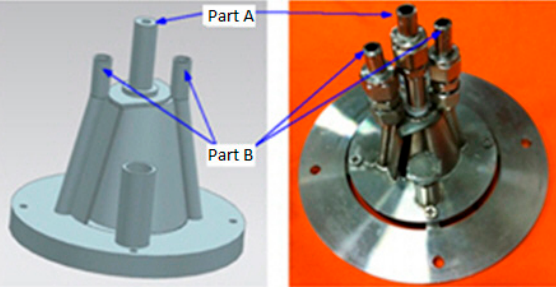
Figure 3. Model (left) and the physical object (right) of the conical swirler with two parts of fuel.